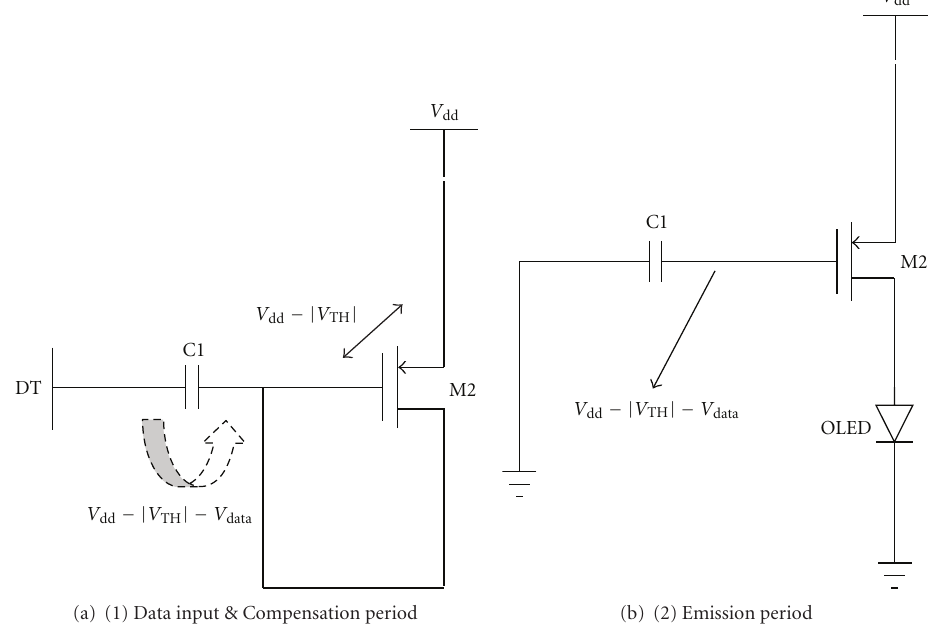
Figure 2: Operation of the proposed pixel circuit in equivalent two stages: (1) data input and compensation period, (2) emission period.